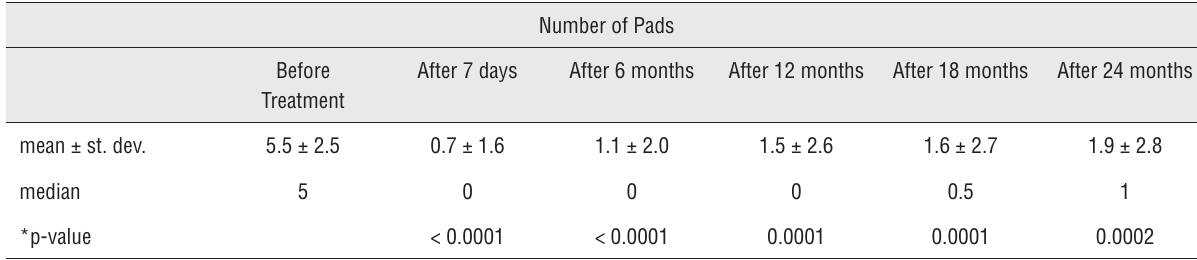
Table 2 - Number of pads used by the patients before and after treatment with Bulkamid®.